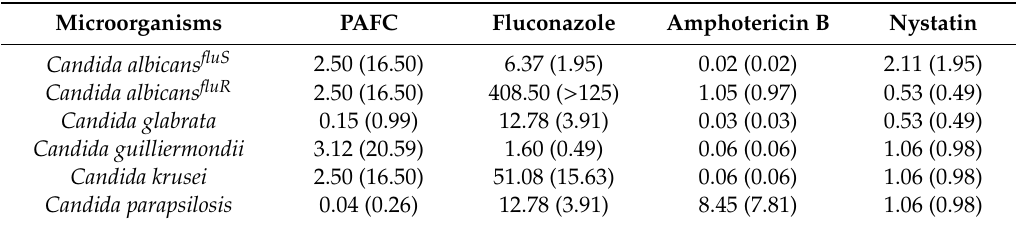
Table 1. Inhibitory concentrations of PAFC and commonly used antifungal drugs reducing Candida spp. growth ≥ 90% (IC 90 ) §